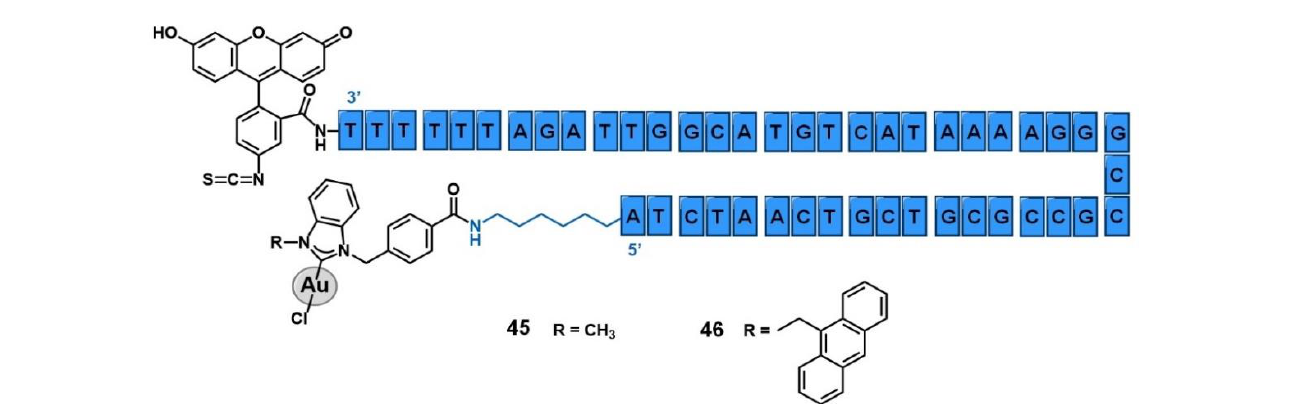
Figure 14. Ru(II) and Au(I) conjugates that target different organelles of cancer cells: 41 is specific for hepatoma cells membrane, 42 and 43 are specific of the mitochondria, and 44 to 46 include specific oligonucleotides for targeted delivery. Note that only a part of conjugate 42 is depicted (from amino acid 312 to 324 of the human serum albumin protein). VDAC = mitochondrial voltage-dependent anion-selective channels.